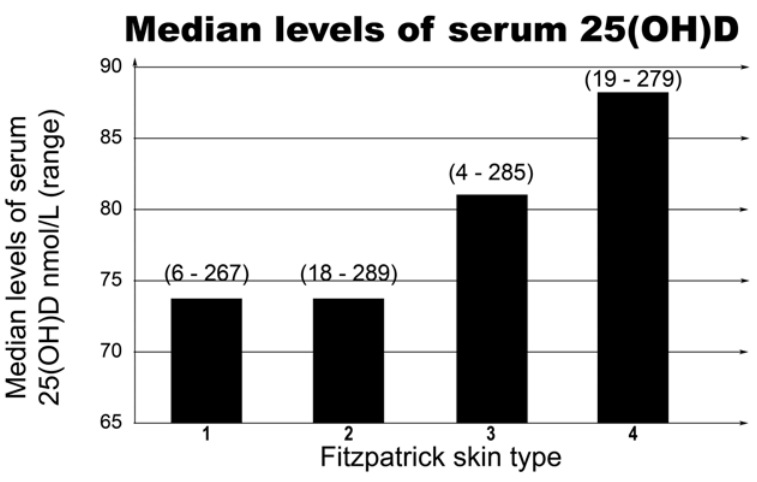
Figure 1. Median levels of serum 25(OH)D for each skin type.